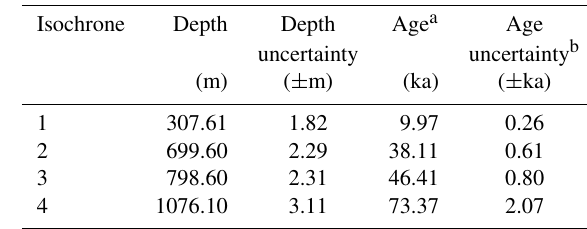
Table 1. Radar isochrones and their uncertainties at the Dome C ice core